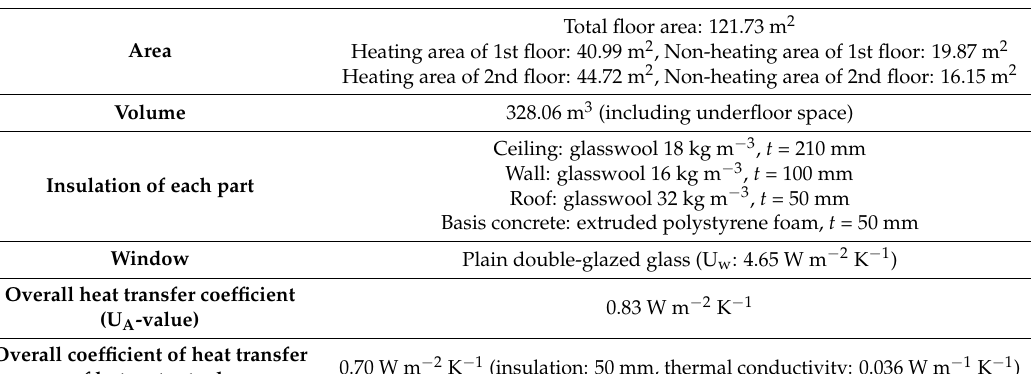
Figure 2. Target building (units: mm). ( a ) plan; ( b ) elevation. Reproduced from [32], publisher: 2010. Table 1. Specification of target building.